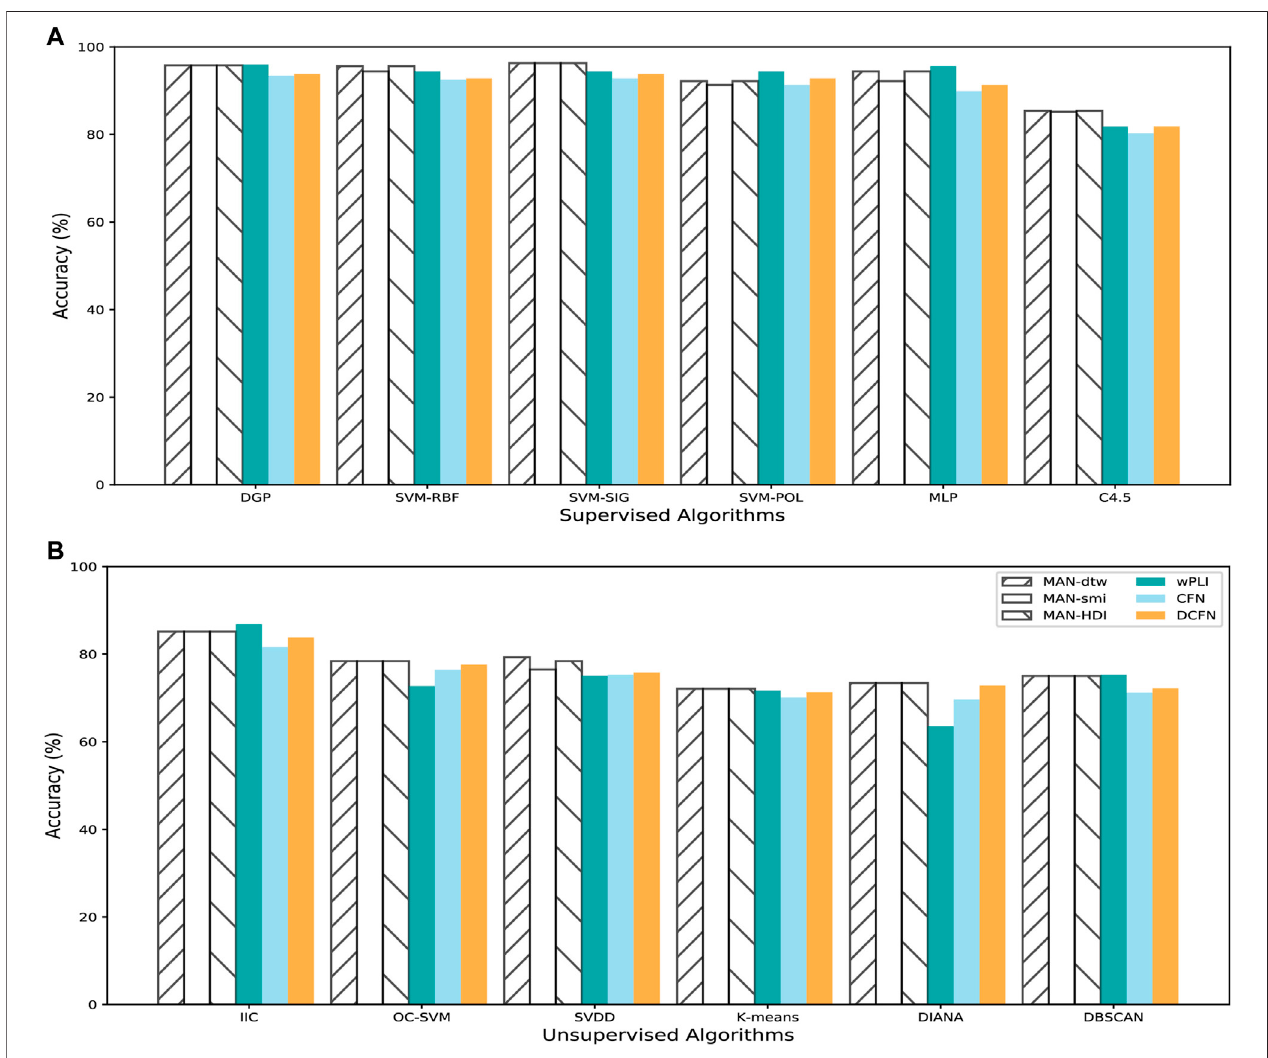
FIGURE 3 | Comparison between different methods of brain functional network construction in detecting mental fatigue with 6 supervised classi fi ers and 6 unsupervised classi fi ers. Comparison in (A) supervised and (B) unsupervised classi fi ers.